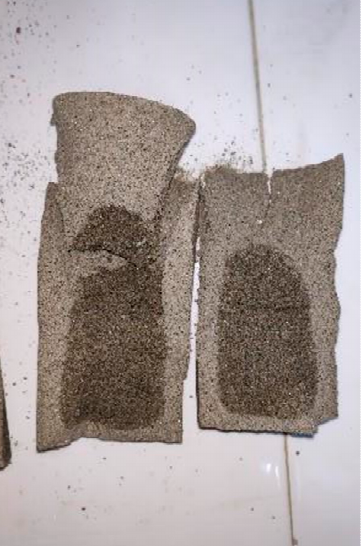
Figure 16. The area with uneven moisture content in the sample